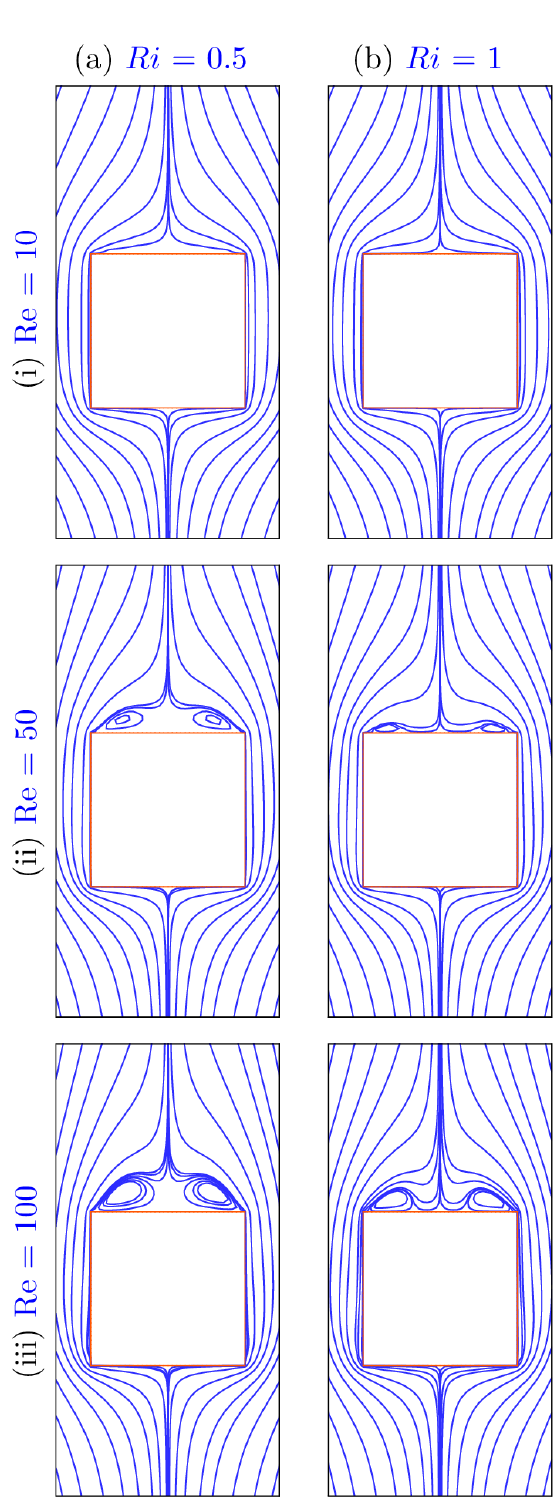
Figure 4. Time-averaged streamlines for different values of Re at φ = 5% for ( a ) Ri = 0.5 and ( b ) Ri = 1.